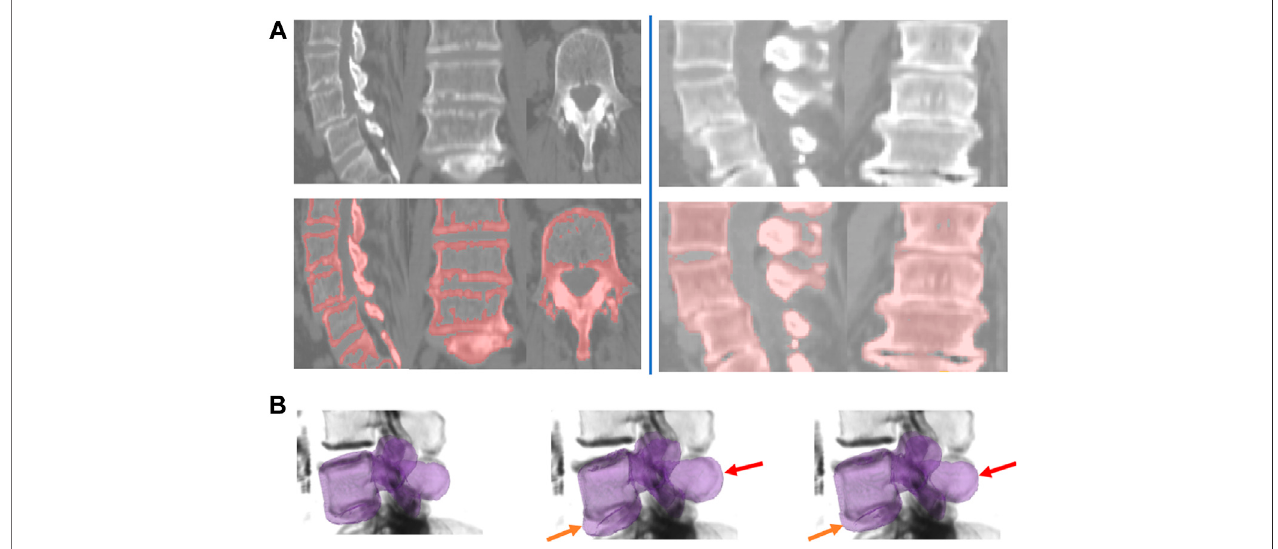
FIGURE 10| Shape-prior based segmentation in pipeline 2. (A) Region-based segmentation Pipeline1 applied to two example subjects from Database 3 with the pathology cases. Left :Sampleslicesshown fortheregion-based surfaceextractionon the fl ux-map forDatabase 3. Right :Sampleslices shownfortheshrink-wrapping processforDatabase3. (B) Intermediatestepsfortheshape-priorbasedsegmentationprocessforasubjectfromDatabase3.Leftcolumn:shape-priorinitialization.The middle and rightmost columns shows how the vertebral body and the spinous process are pulled-in (shown by orange and red arrows respectively) and evolve to segment the individual